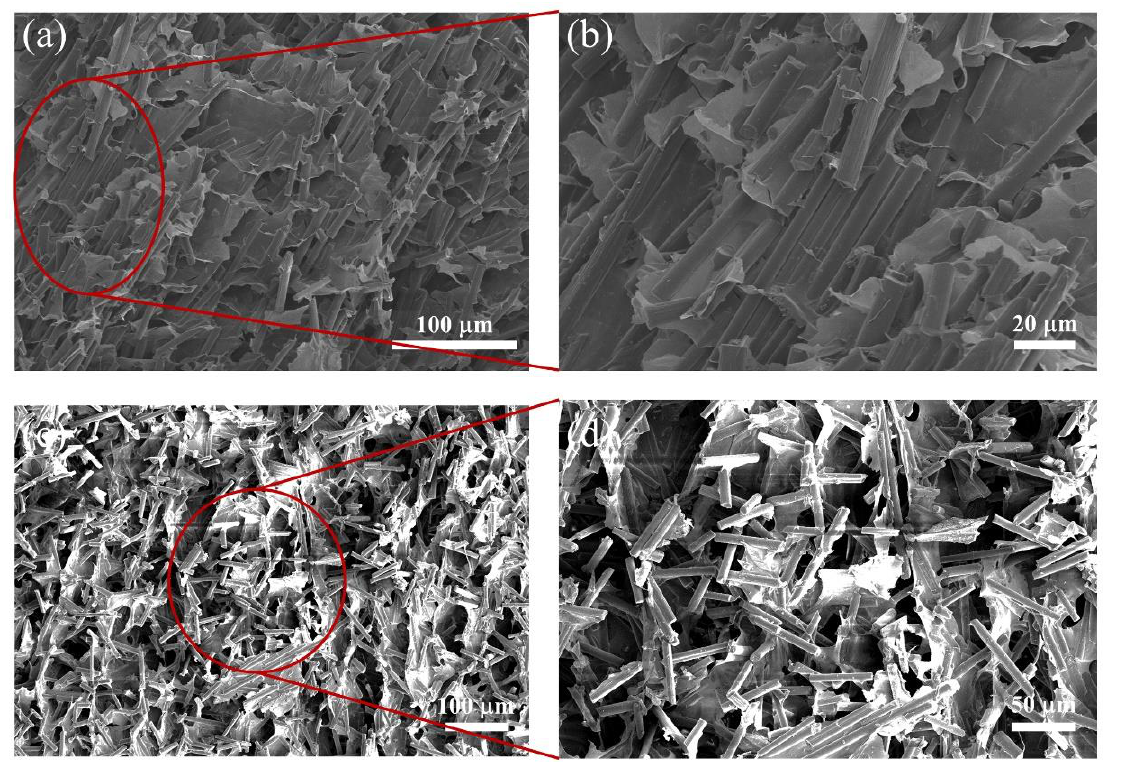
Figure 3. ( a , b ) Fracture surface SEM images of the CF scaffolds with the addition of CMC, ( c , d ) Fracture surface SEM images of the CF scaffolds without